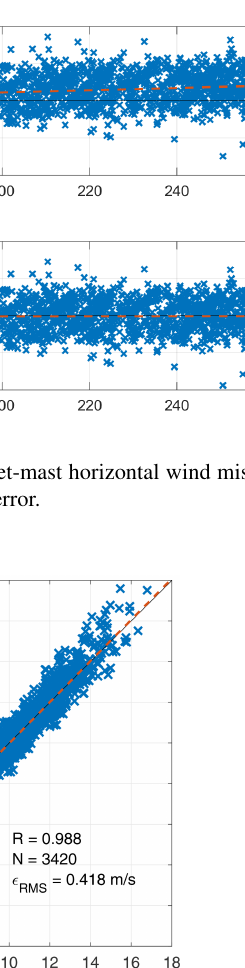
Figure 6. Correlation between 10min averages of met-mast hub- height wind speed V MM and rotor-effective wind speed V TB esti- mated with the torque balance equation. Dashed red line: linear best fit; dashed black line: ideal match; R : Pearson’s correlation coeffi- cient; N : number of data points available; (cid:15) RMS : root mean square error.